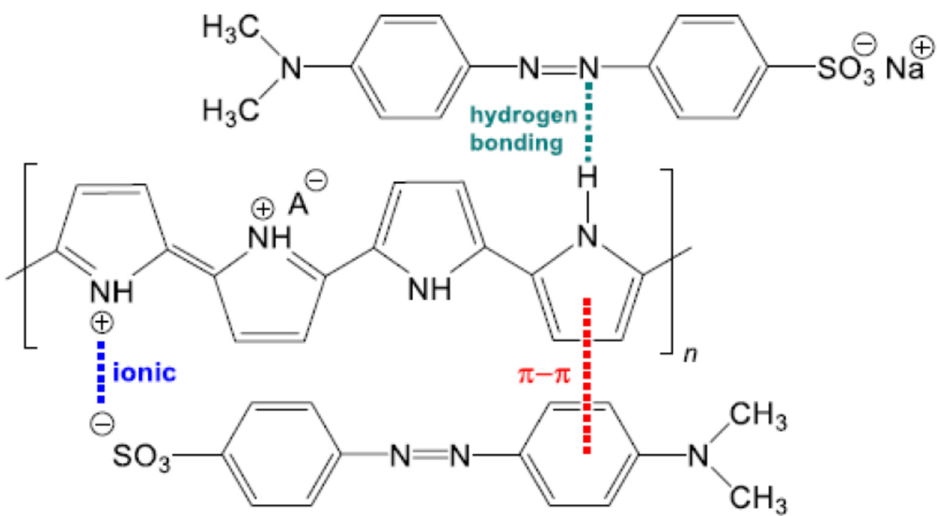
Figure 7. π – π interactions and hydrogen bonding between organic dye methyl orange and Ppy. Reprinted with permission from Ref. [130]. Copyright 2019 Springer Nature. Table 5. Ppy-based adsorbents for the removal of 文献